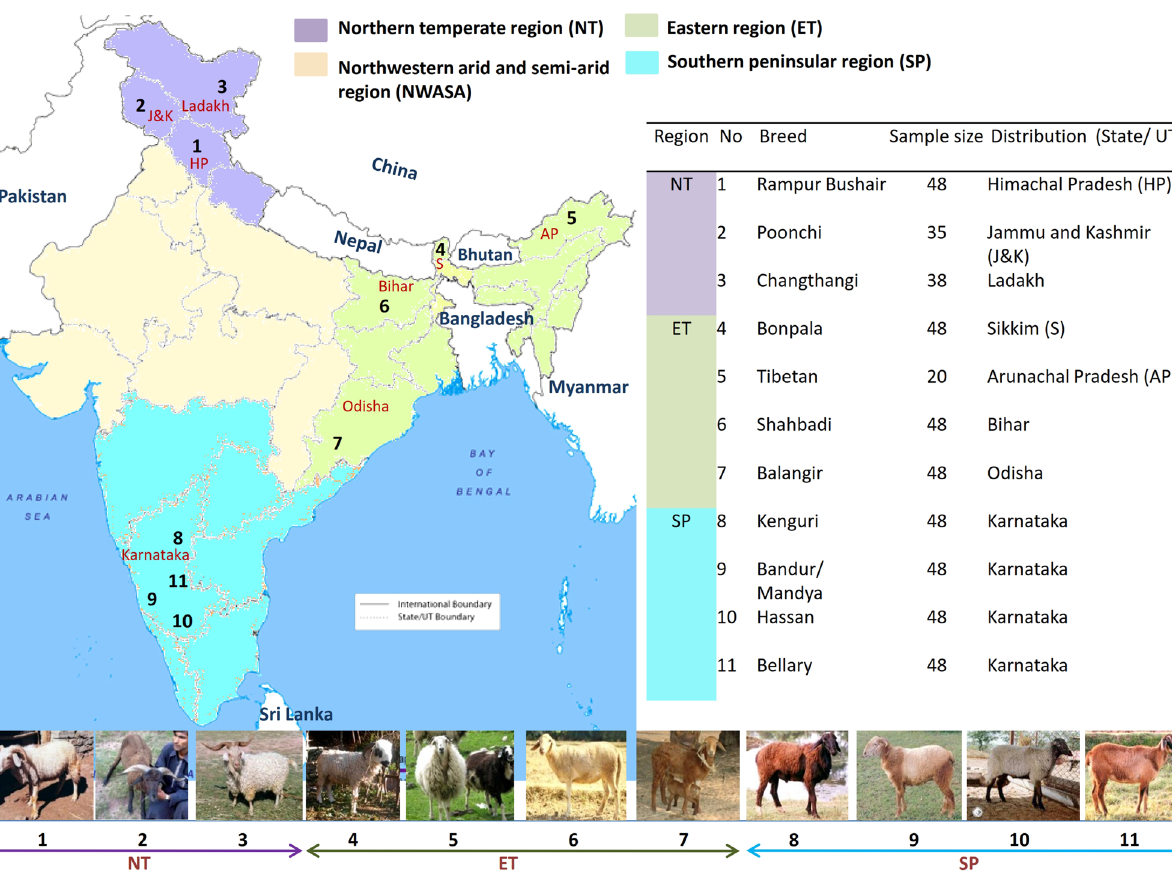
Figure 1. Distribution of Indian sheep breeds included in the study.